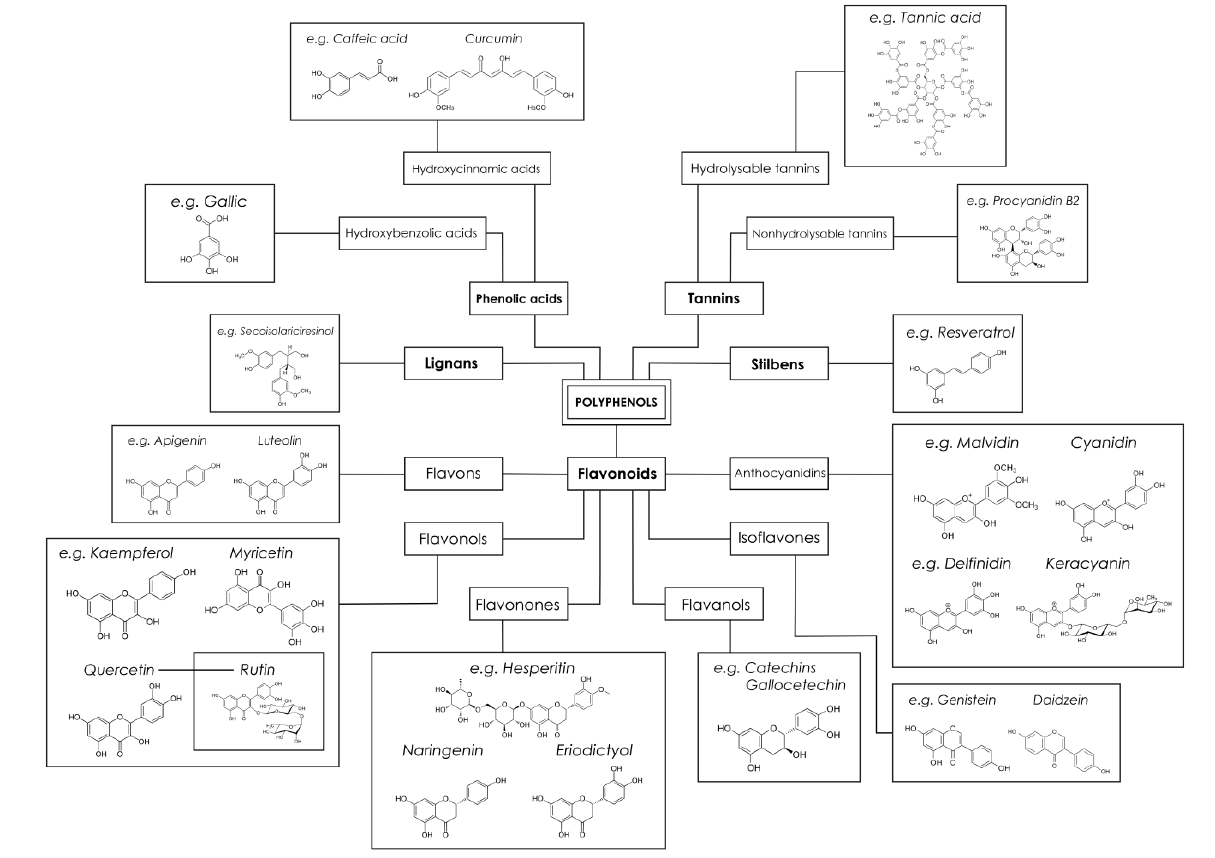
Figure 1. Polyphenols classification.